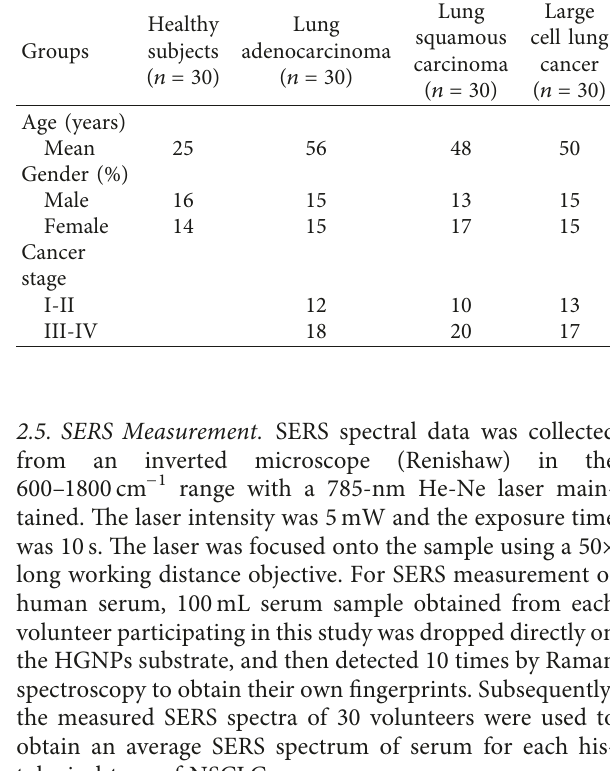
Table 1: Demographics of study population.